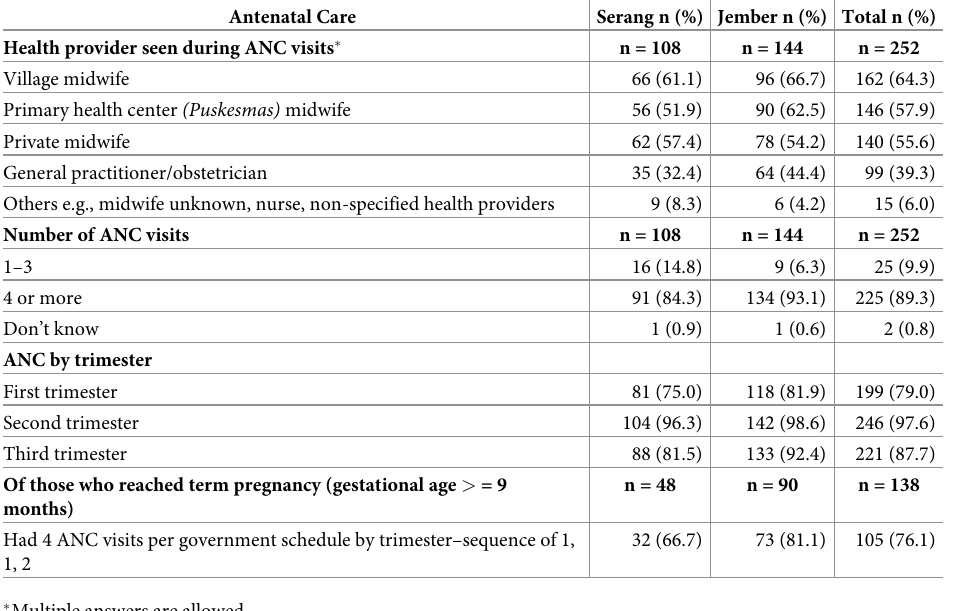
Table 2. Most mothers visited health providers for ANC (98%). However, many also visited traditional birth attendants (28%—not shown in Table 2). Of health providers, midwives were more likely to be consulted for ANC compared to doctors or nurses. Most mothers of deceased neonates (79%) received ANC in the first trimester and 89% received ANC at least four times during their pregnancy. Of those who reached term pregnancy (n = 138), 76% of the mothers had ANC visits according to the government-recommended 1-1-2 schedule. Most neonates (83%) were born at a health facility, with nearly half (47%) born at a hospital, as seen in Table 3. Eighty-six percent of the 37 home births were not assisted by an SBA. Table 2. Antenatal care characteristics. Antenatal